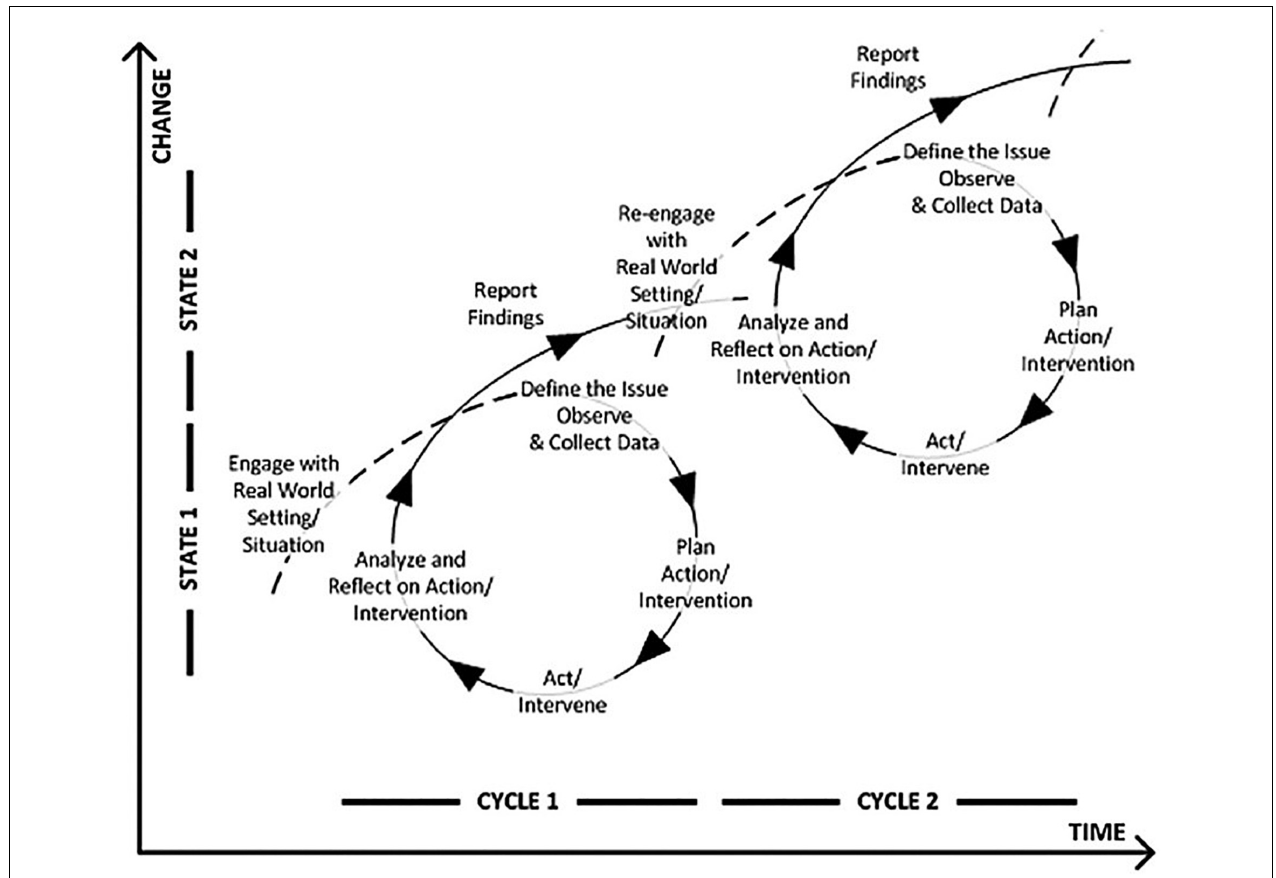
FIGURE 1 | Action research cycle (image from www.brighthub.com, redrawn by Iris D. Tommelein and reprinted with permission from Carly Stockwell).